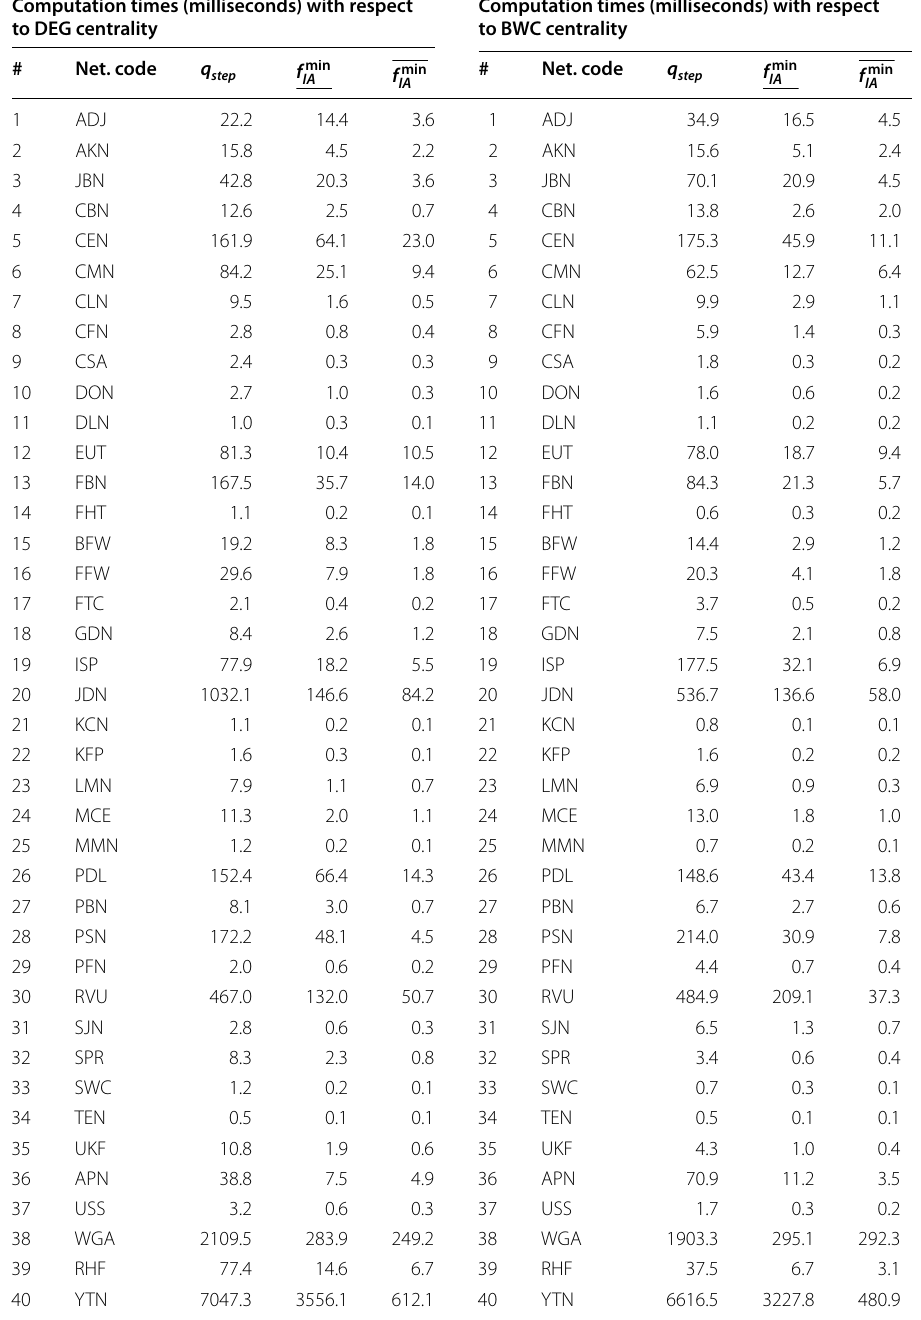
Table 6 Computation times for the q Computation times (milliseconds) with respect to DEG centrality